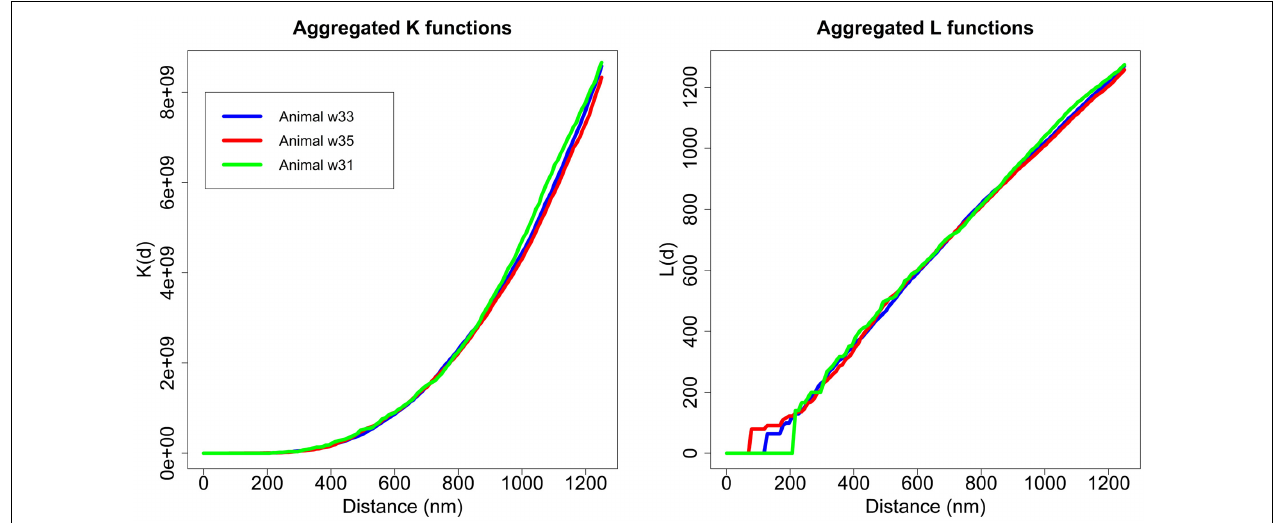
FIGURE 6 | Aggregated K and L functions for each animal. The Diggle test found no significant differences between the three animals used in the study.